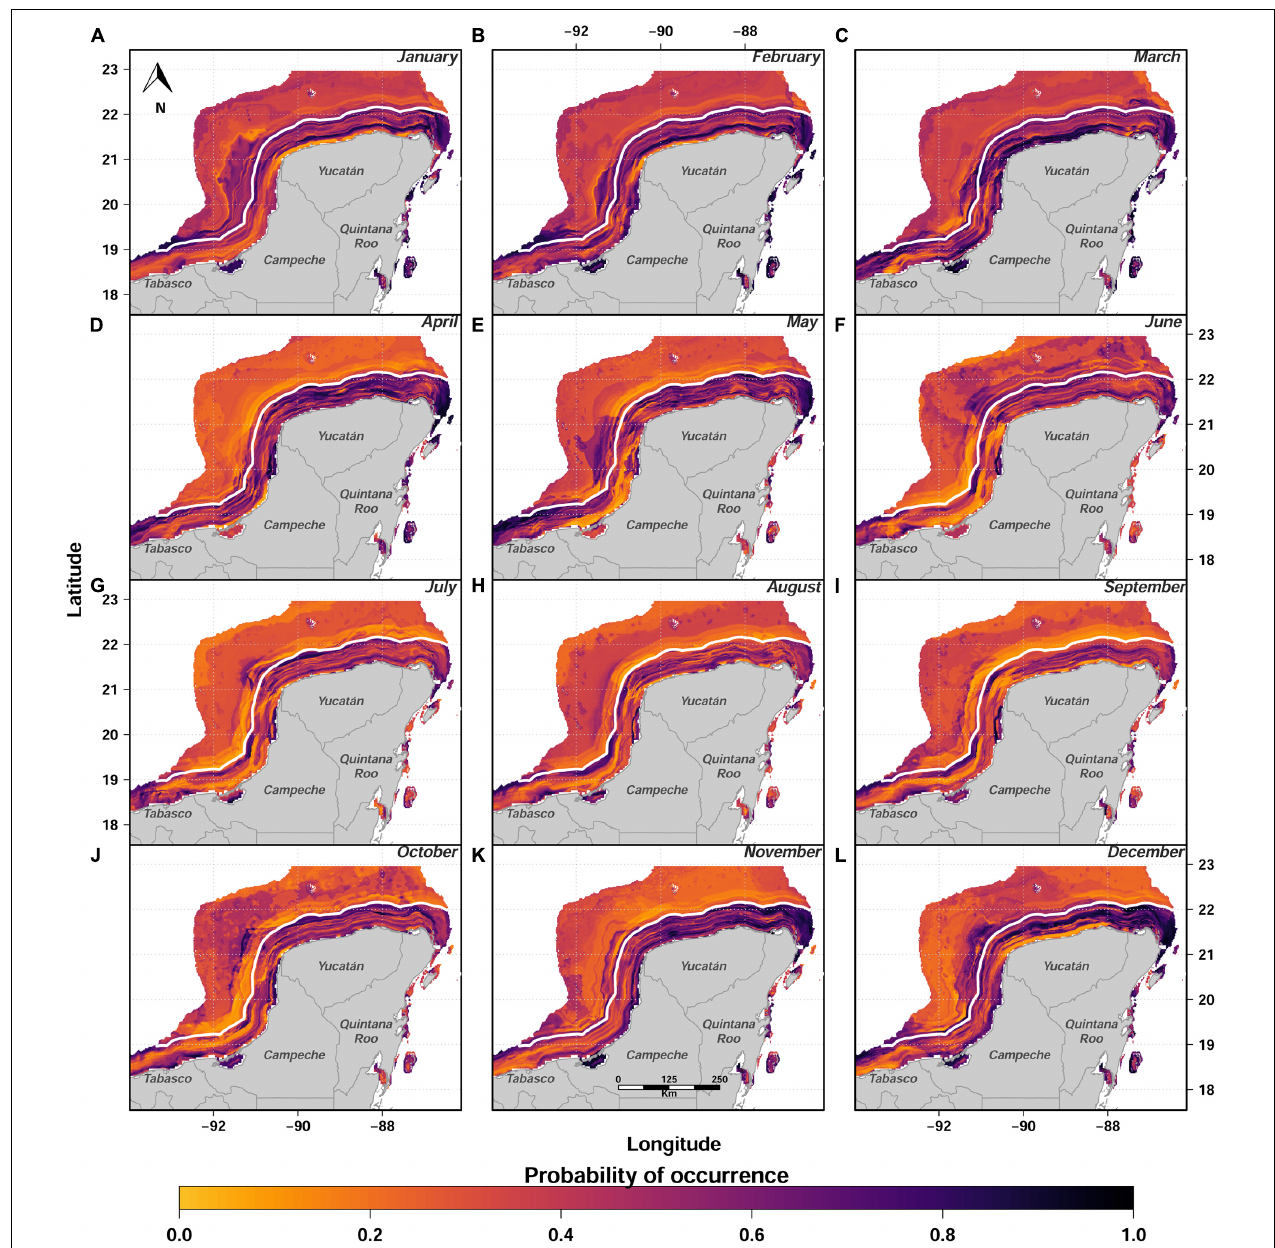
FIGURE 4 | Monthly ensemble model forecasting (median ensemble model; A-L ) for potential fishing grounds. Color scale represents the probability of occurrence of fishing activities given certain environmental conditions; the darker the color, the higher the